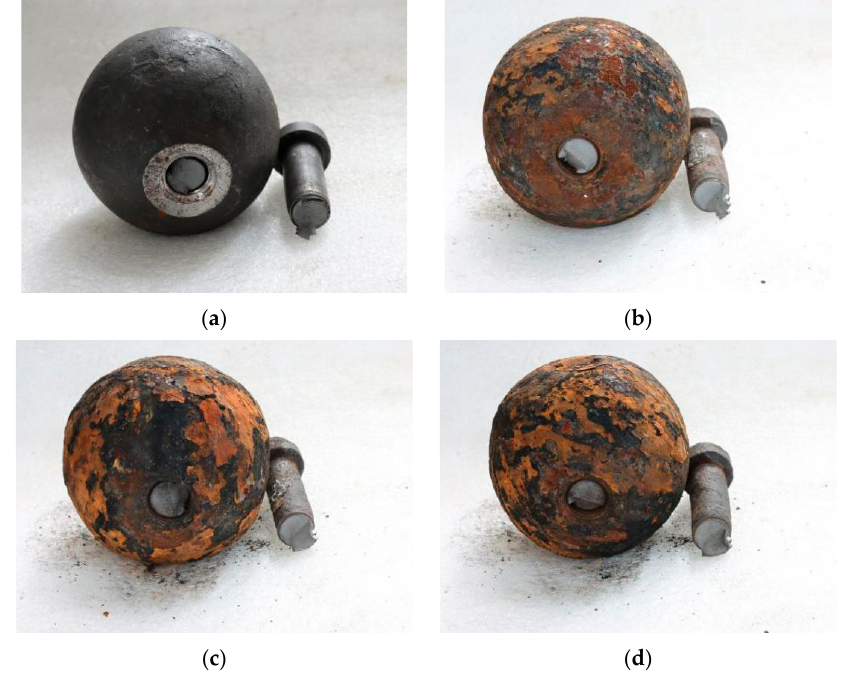
Figure 8. Fractures of individual specimens: ( a ) C-0; ( b ) C-1; ( c ) C-2; ( d ) C-3.